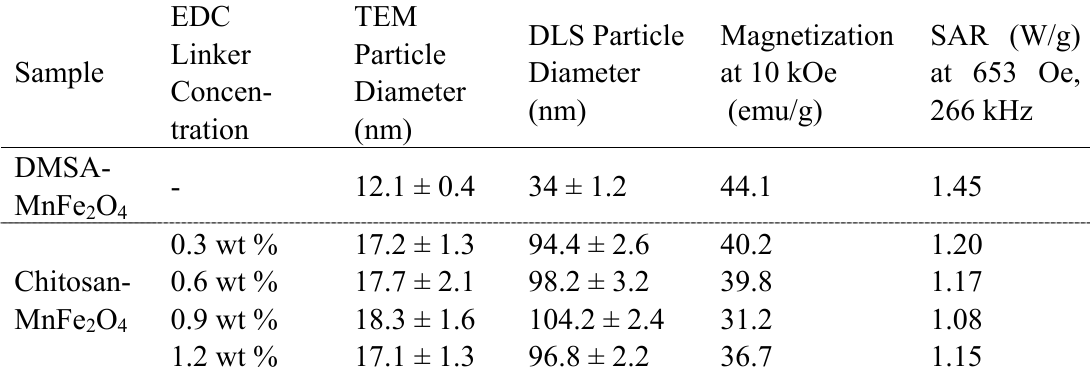
O and chitosan-MnFe 2 4